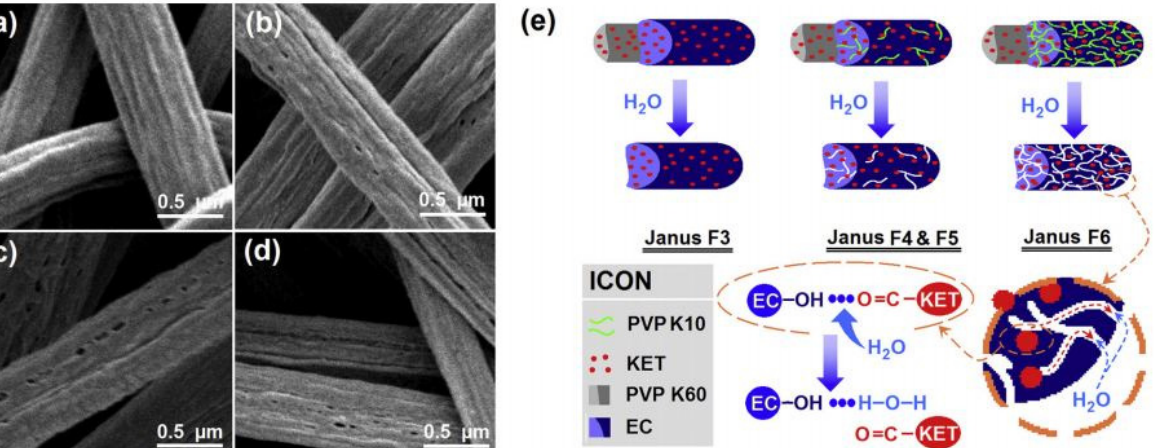
Figure 20. FESEM images of the fibers remaining after 24 h of dissolution ( a – d ) and proposed mech- anism of drug release from Janus fibers ( e ) (reprinted from reference [174] with permission from Elsevier).